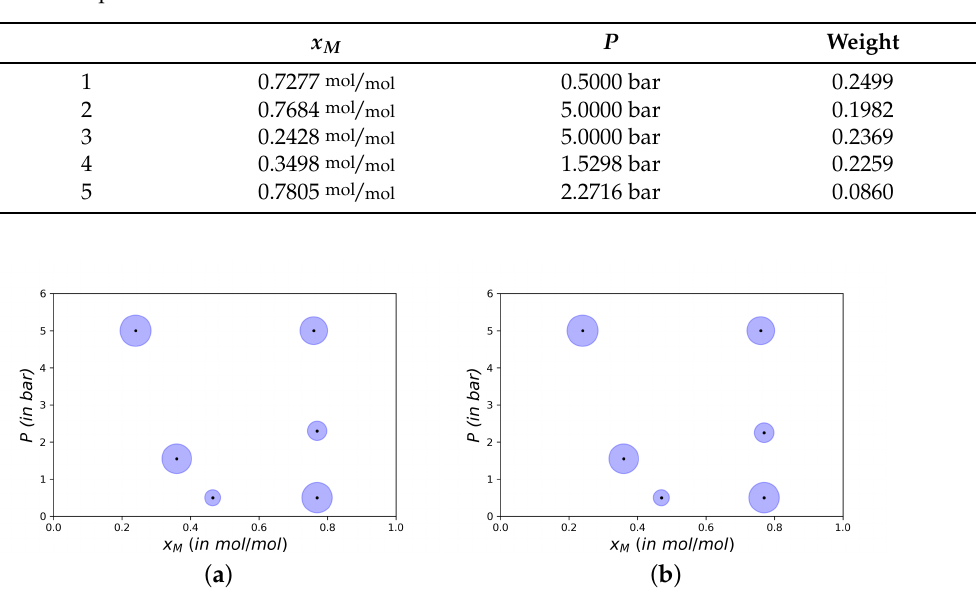
Table 8. Optimal design ξ ADAGPR computed with the ADA-GPR for the flash with a methanol– acetone input feed.